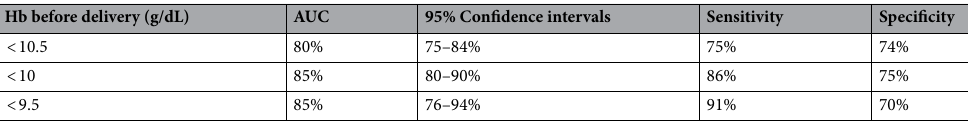
Table 2. Prenatal anemia prediction accuracy of Hb < 10.6 g/dL between 24 and 30 gestational week to predict anemia before delivery using ROC curve analysis. ROC curve analysis was used to predict anemia at delivery. AUC, area under the curve; ROC, receiver operating